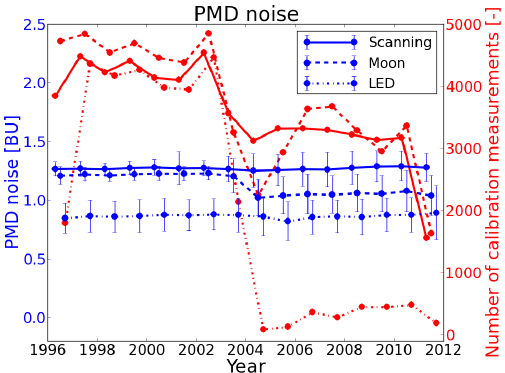
Figure 14. Annual mean dark current noise (blue curves, left y axis) in binary units (BU) for three integration time patterns: scan- ning (solid curve), moon (dashed curve), and LED (dotted–dashed curve). Red curves (right y axis) denote the number of available calibration measurements for the three individual time patterns.